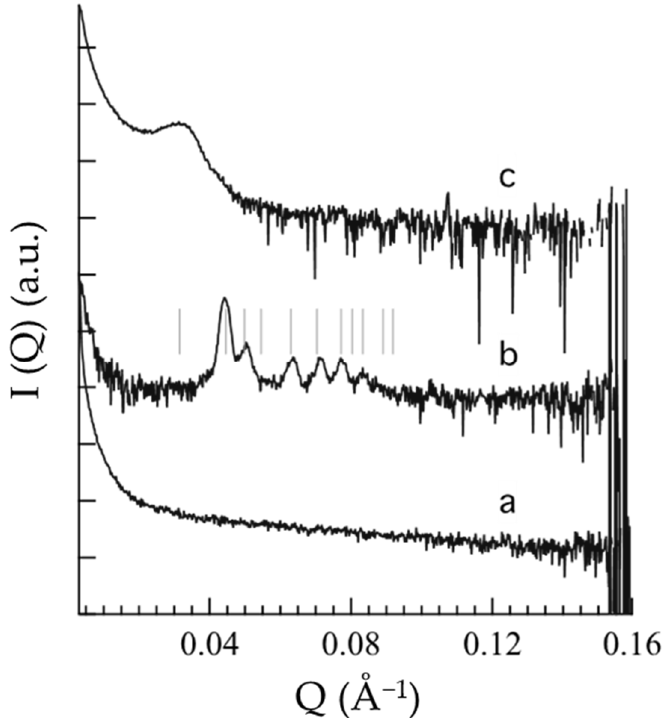
Figure 2. Small-angle X-ray scattering profiles of OG ( a ), POL ( b ) and POG ( c ). The thin vertical lines superposed to the b SAXS profile indicate the position of the Bragg peaks permitted for the Pm3n symmetry; note that Bragg peaks could be absent for other reasons than symmetry [41].